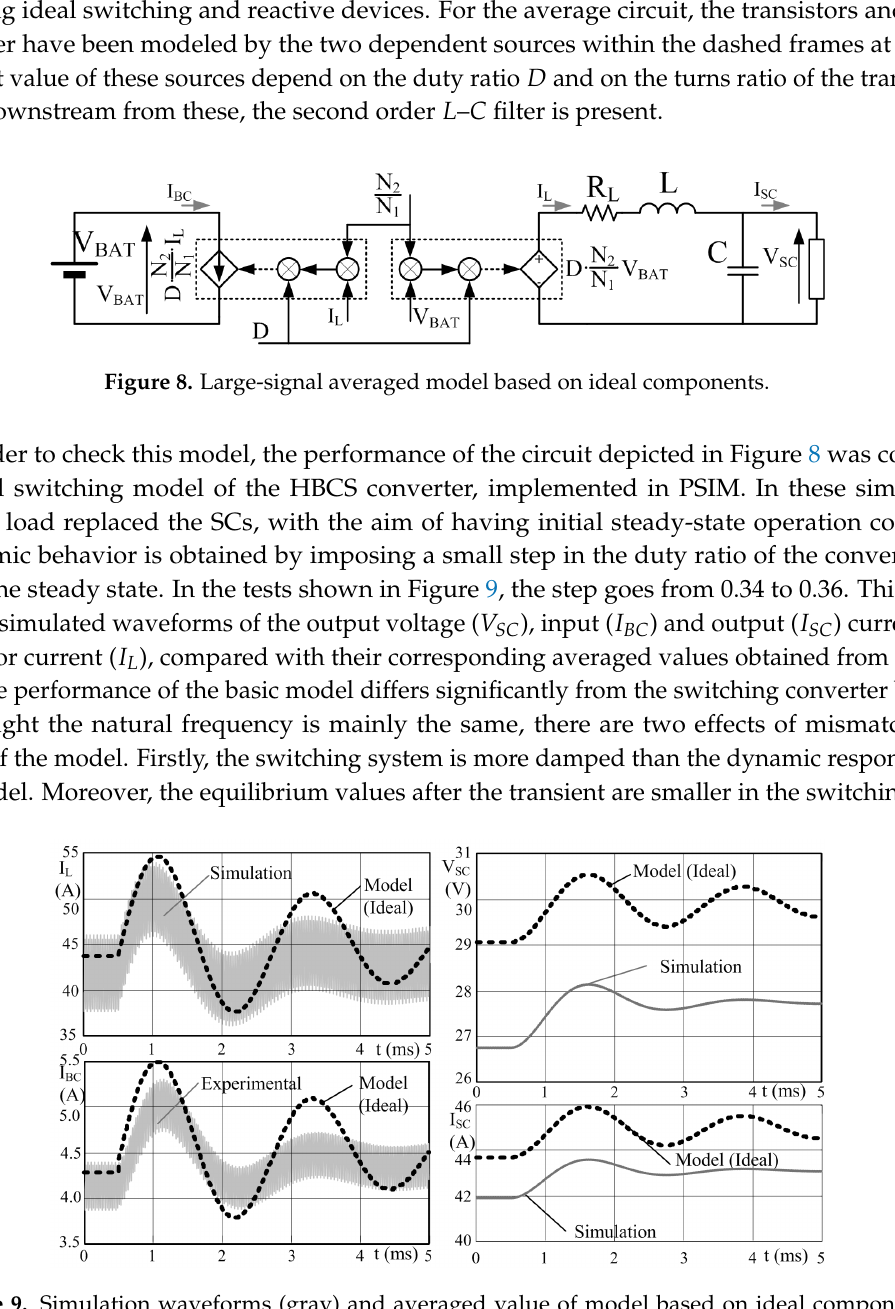
Figure 9. Simulation waveforms (gray) and averaged value of model based on ideal components (black), for filter current ( I L ), load output current ( I SC ), load voltage ( V SC ), and input current ( I BC